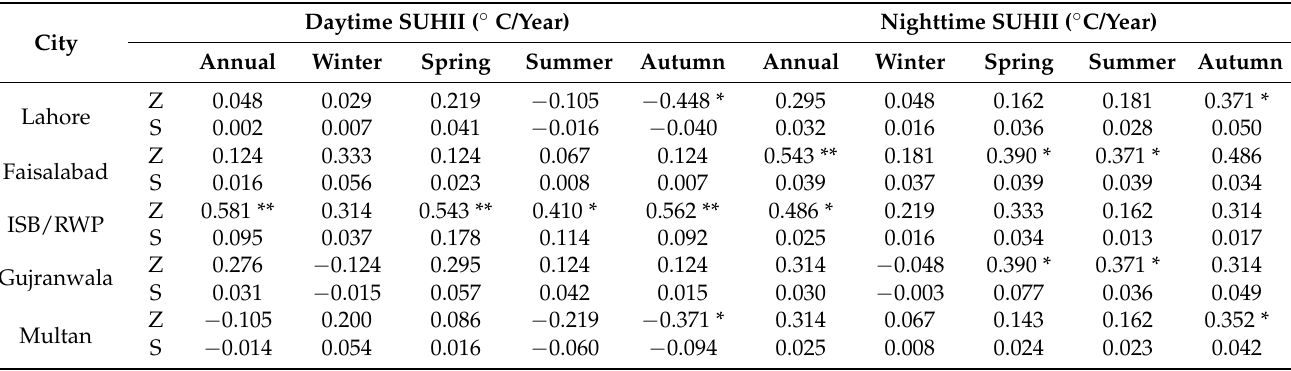
Figure 5. Trends for averaged nighttime SUHII. Table 4. The last 15 years of temporal trends of SUHII for Punjab (Z represents the MK value and S represents the Sen’s slope